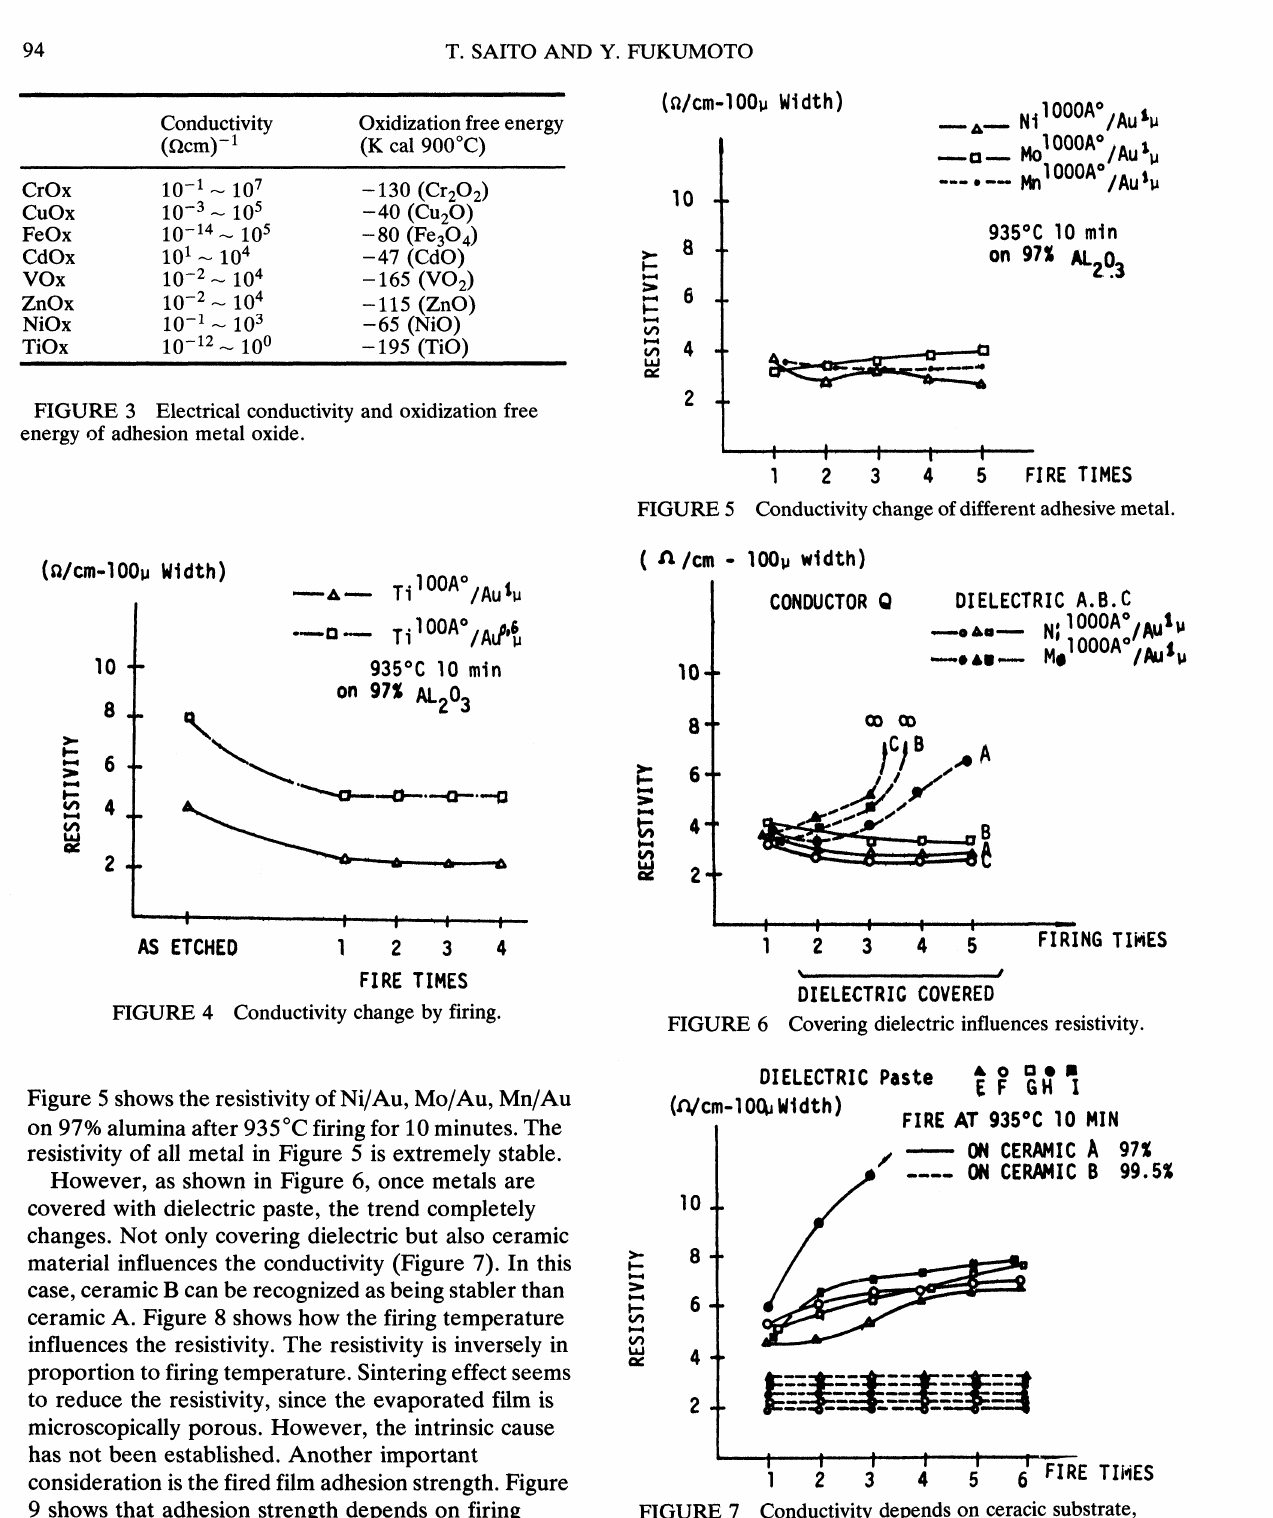
FIGURE 7 Conductivity depends on ceracic substrate, covering dielectric and firing